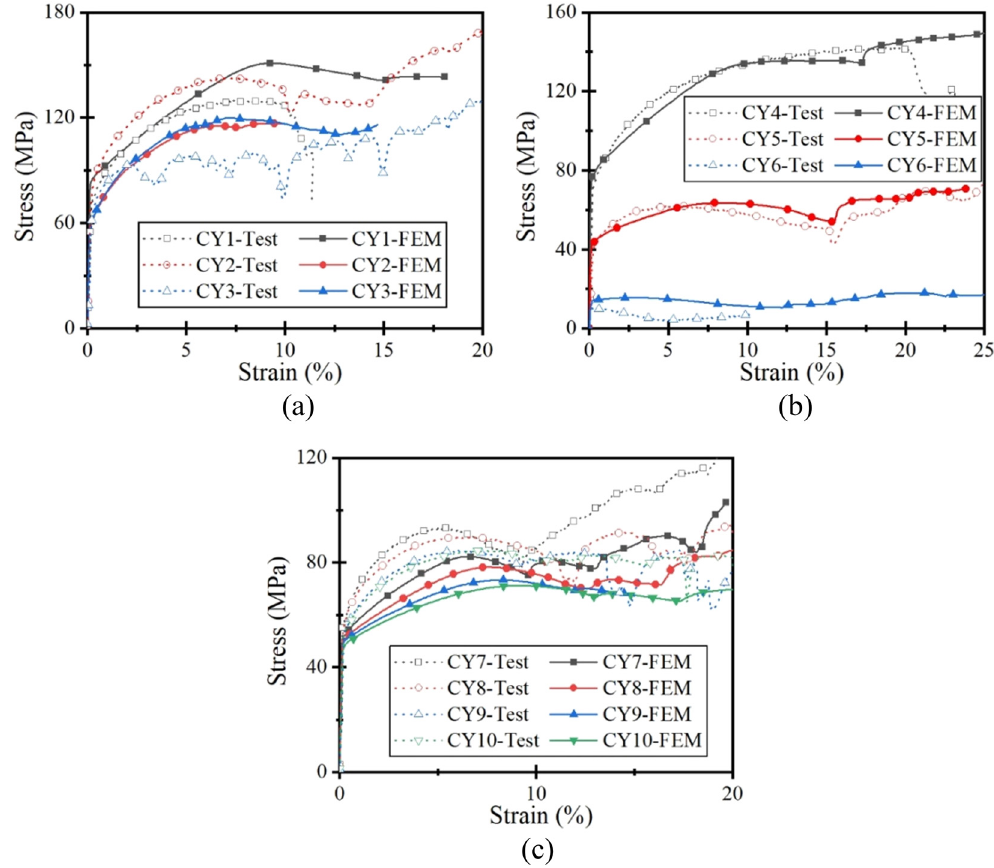
Figure 14: Comparison between experimental results and simulations: ( a ) specimens CY1, CY2, and CY3, ( b ) specimens CY4, CY5, and CY6, and ( c ) specimens CY7, CY8, CY9, and